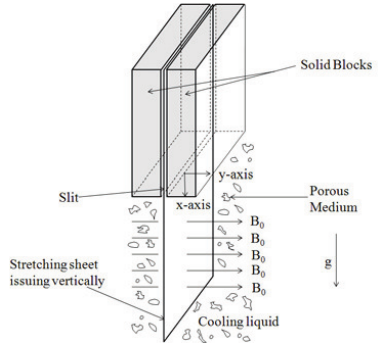
Figure 1. Physical model and coordinate